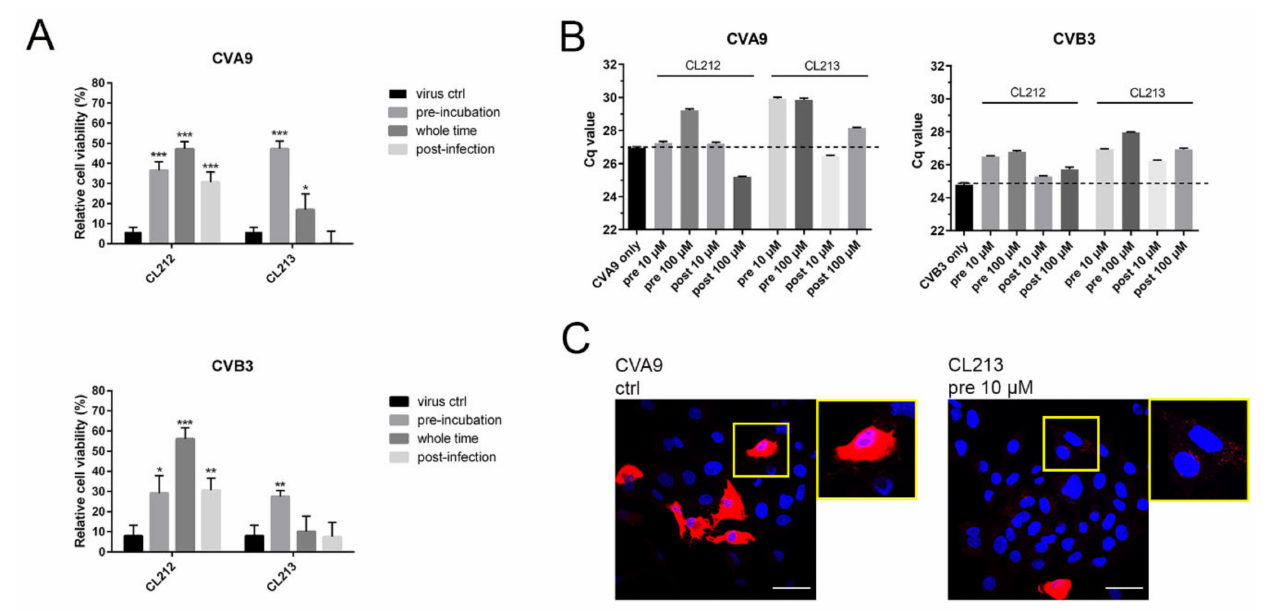
Figure 4. CL212 and CL213 prevent CVA9 infection already after pre-incubation but have less efficacy against the Nancy strain of CVB3. ( A ) Relative cell viabilities of cells infected with CVA9 or CVB3 (1.6 × 10 7 PFU/mL) for 24 or 48 h after three different treatments with molecule CL212 (100 µ M), or CL213 (10 µ M against CVA9, 100 µ M against CVB3). The molecules were either incubated with the virus for 1 h before infection, were added to cells 1 h post-infection or were present the whole pre-incubation and infection period. Virus control samples were with no molecule treatment. CVA9 graphs show viabilities from four (CL212) or three (CL213) separate experiments each containing three technical replicates. CVB3 graphs show viabilities from two separate experiments each containing three technical replicates. The data is normalized against an uninfected cell control and presented as mean ± SEM. From comparison to virus control samples significant p-values are marked with an asterisk above the respective sample columns: p < 0.05 *, p < 0.01 **, and p > 0.001 ***. ( B ) A549 cells were infected with CVA9 or CVB3 for 5.5 h and the amount of viral RNA was detected using qPCR. CL212 and CL213 were either pre-incubated with the viruses for 1 h before infection or were added 2 h p.i. ( C ) A549 cells were infected for 5.5 h with CVA9 with or without pre-incubating the virus with CL213 for 1 h. The infection was detected by immunolabeling the viral capsid protein VP1 (red). The cell nuclei were visualized using DAPI staining (blue). Scale bars 40 µ